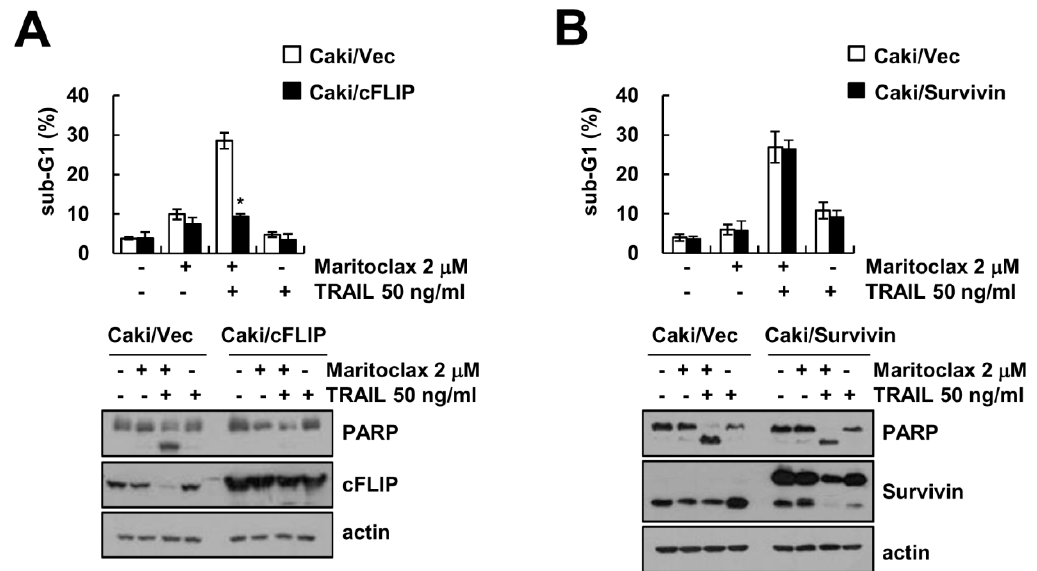
Figure 4. The ectopic expression of cFLIP inhibits maritoclax plus TRAIL-induced apoptosis. ( A , B ) Vector cells (Caki/Vec), cFLIP overexpressed cells (Caki/cFLIP) and survivin overexpressed cells (Caki/Survivin) were treated with 50 ng/mL TRAIL in the presence or absence of 2 µ M maritoclax for 24 h. The sub-G1 fraction was measured by flow cytometry. The protein expression levels were determined by Western blotting. − , no treatment; +, treatment. The values in graph ( A , B ) represent the mean ± SD from three independent samples. * p < 0.05 compared to the maritoclax plus TRAIL-treated Caki/Vec by ANOVA and Student-Newman-Keuls methods.